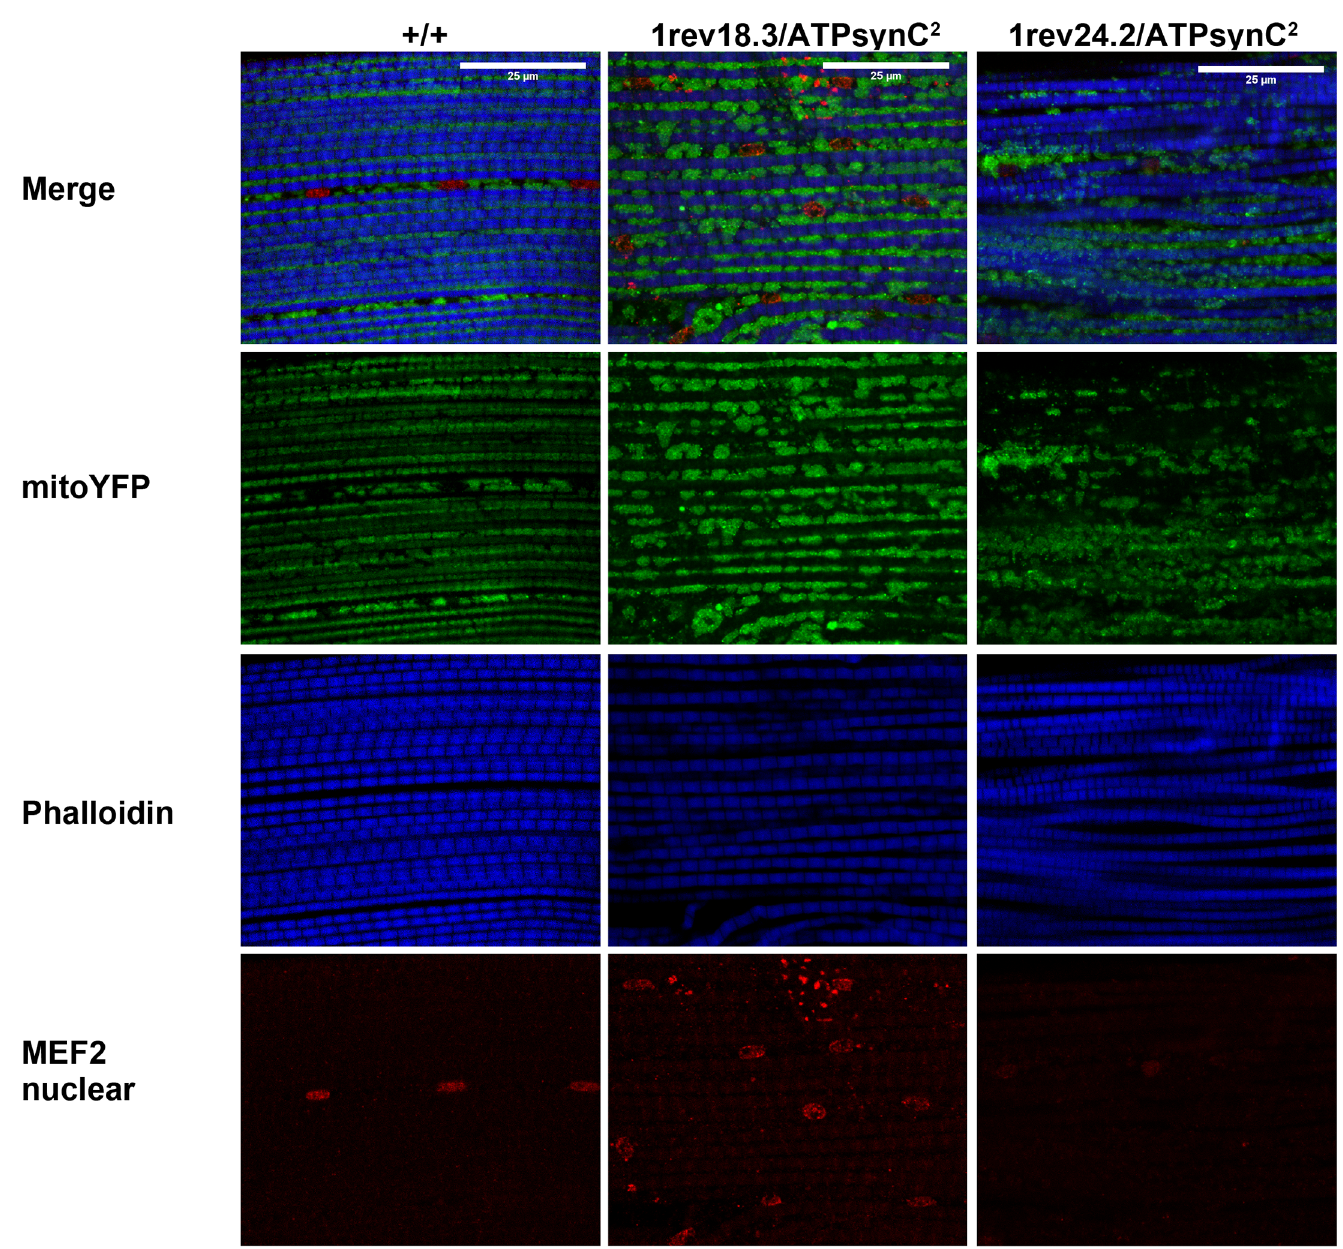
Fig 8. Mitochondrial ultrastructure in trans-heterozygotes for representative ATPsynC 1 revertant alleles. Thoracic muscles from Oregon-R wild-type flies plus mutant flies ATPsynC 1rev18 .3 and ATPsynC 1rev24 .2 , stained with an anti-GFP antibody selective for mitochondria in green, an anti-phalloidin antibody to label myofibrils in blue, and an anti MEF2- antibody for nuclear localization in red. Oregon-R flies showed a tubular mitochondrial networks that enclose myofibrils with big aligned nuclei. Mitochondria are bigger and clumping with a slight alteration of mitochondrial network in ATPsynC 1rev18 .3 mutants, whereas in ATPsynC 1rev 24.2 flies mitochondria are smaller, clumped and badly organized around